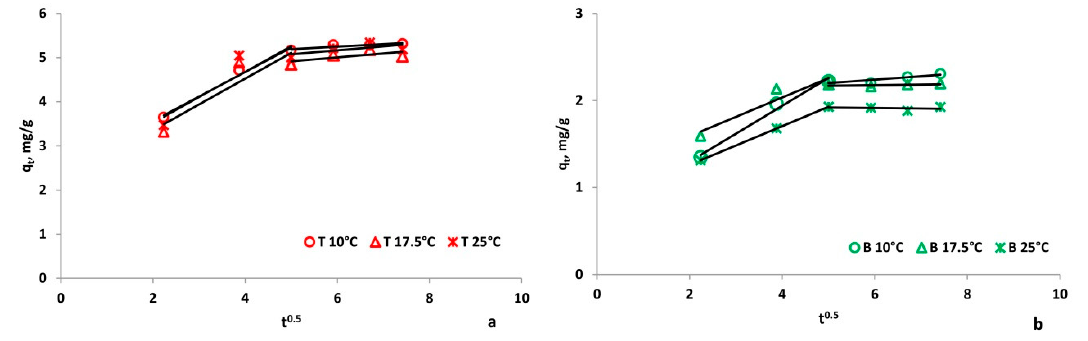
Figure 6. Liquid film diffusion kinetic plot for Mn sorption on: ( a ) tuff and ( b ) basalt. Figure 7. Intraparticle diffusion kinetic plot for Mn sorption on: ( a ) tuff (T) and ( b ) basalt (B) in fragmented form. Table 5. Parameters of intraparticle diffusion model, characterized by coefficient of determination and standard deviation.